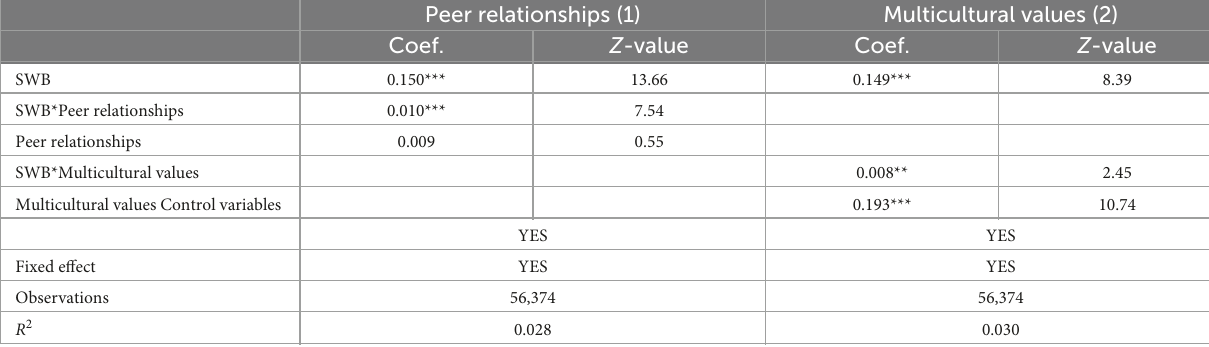
TABLE 8 Moderating effect of peer relationships and multicultural